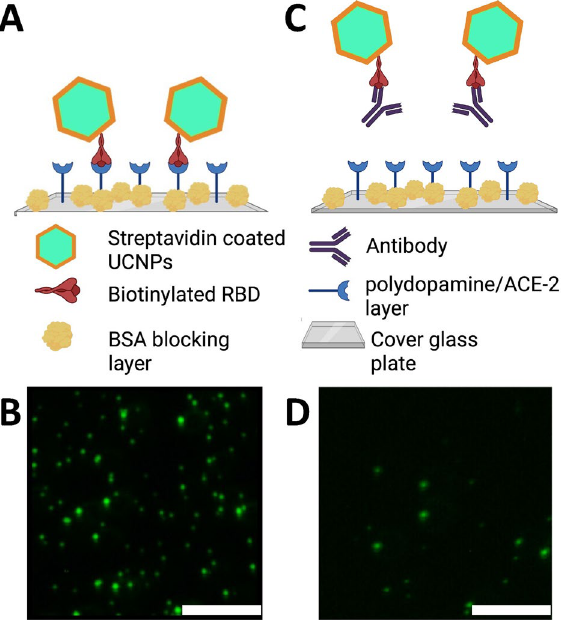
Figure 1. Schematic illustration of the upconversion-based neutralizing assay. ( A , B ) When the antibody is not present (or it is not neutralizing), the phantom virion complex will bind to the ACE-2-coated substrate and particles can be imaged and counted as shown in ( B ). The concentration of UCPVs was 0.4 µ g/ml and no antibodies were present in the solution. ( C , D ) When the antibody is present and it is neutralizing, it will prevent the phantom virion complex from binding to ACE-2-coated substrate and as a result, fewer fluorescent particles will be observed compared to the negative control as shown in ( D ). The concentration of UCPVs was 0.4 µ g/ ml and the concentration of the antibody was 3.23 µ g/ml. Scale bars represent 15 µ m. ( A , C ) Were created with